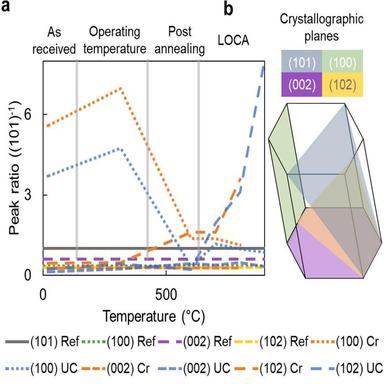
(a) Change in ratio of peak height to the (101) peak height across temperatures in the α-Zr phase; (b) HCP unit cell with representative cubic planes highlighted.